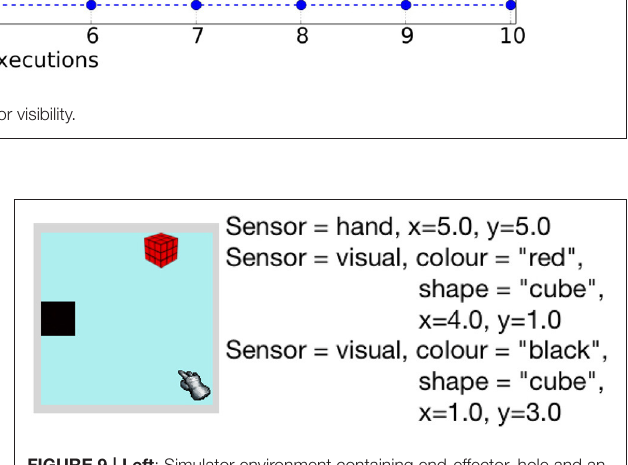
using high-level motor babbling, the agent will be able